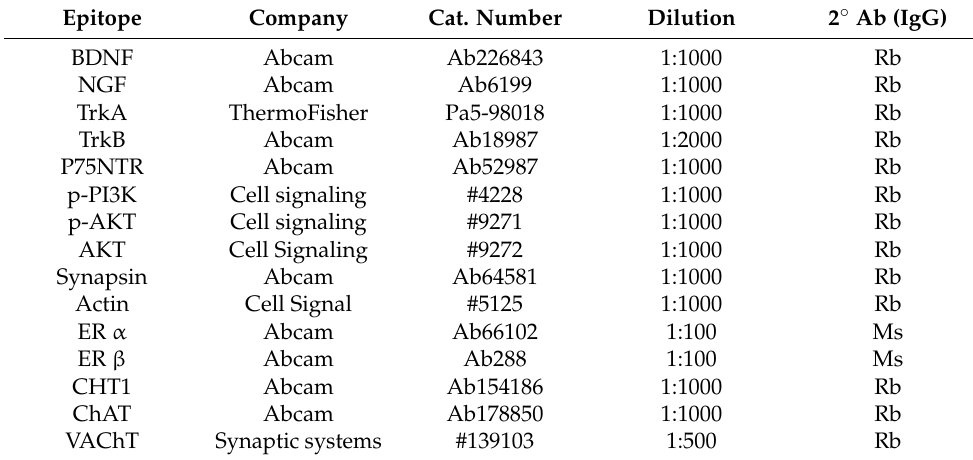
Table 2. List of antibodies used in the current